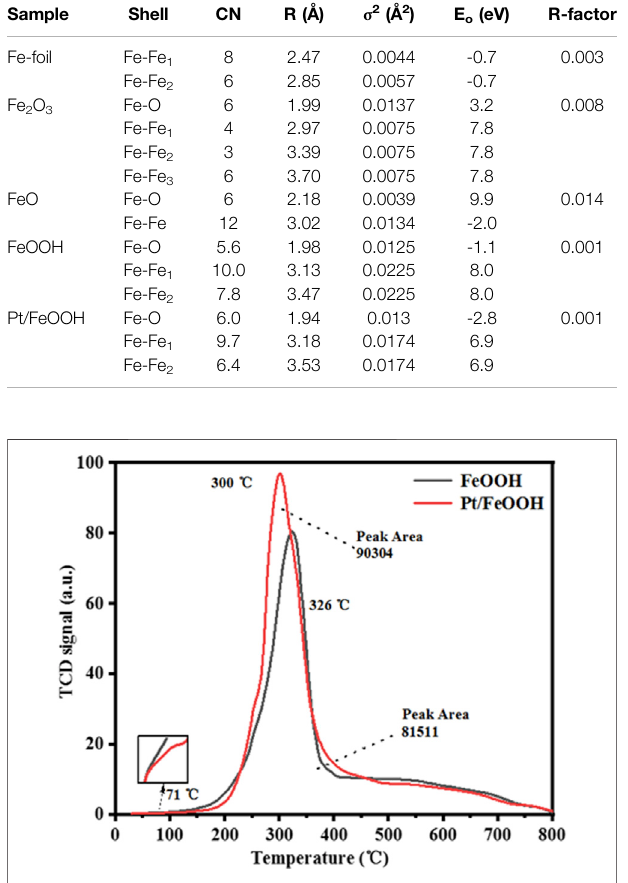
FIGURE 6 | H 2 -TPR pro fi les of FeOOH and